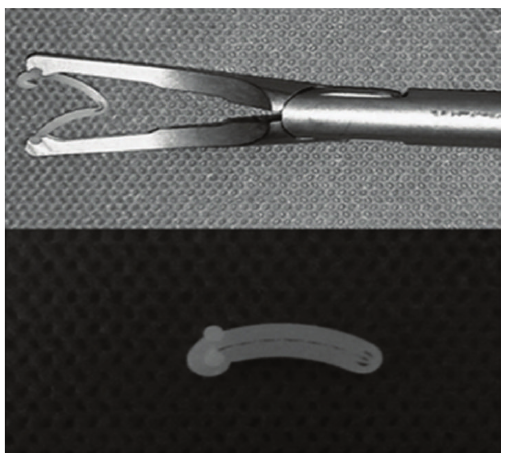
Figure 2: The Hem-o-Lok clips at anterior wall of the first part of duodenum.